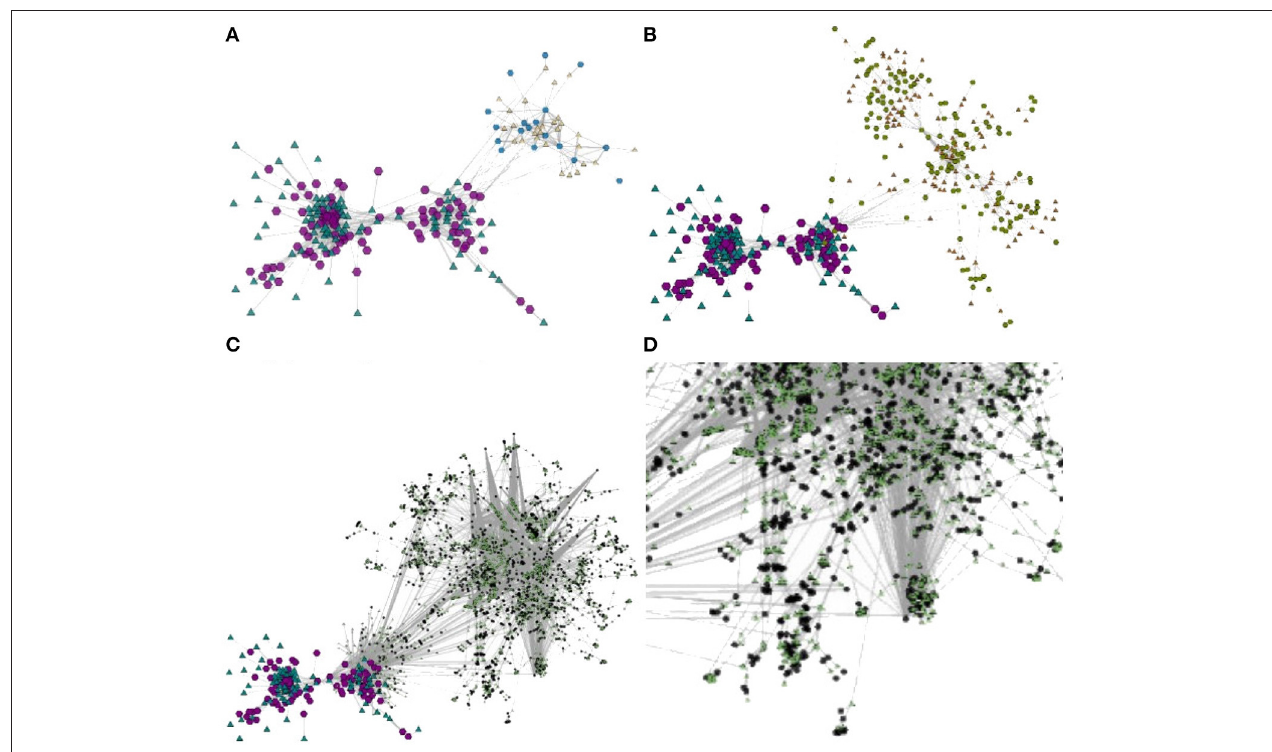
FIGURE 7 | Departing from the coarsest network (level 3) depicted in Figure 6B , with just 100 nodes in each layer, one may select nodes for progressively more detailed visualizations. This is illustrated assuming a selection of the nodes enclosed within the black curve in Figure 6B . In (A) the selection is rendered at coarsening level 2; in (B) it is rendered at coarsening level 1; and in (C) it is rendered at level 0, equivalent to the original network. The non-selected nodes remain rendered at the coarsest level 3. Panel (D) shows a zoomed-in view of the drawing in (C) . These hybrid renderings, depicting the network at different levels-of-detail are created on-demand as a user interacts and selects sub-networks, triggering the corresponding uncoarsening operation. Selecting sub-networks to go back to coarser views is also